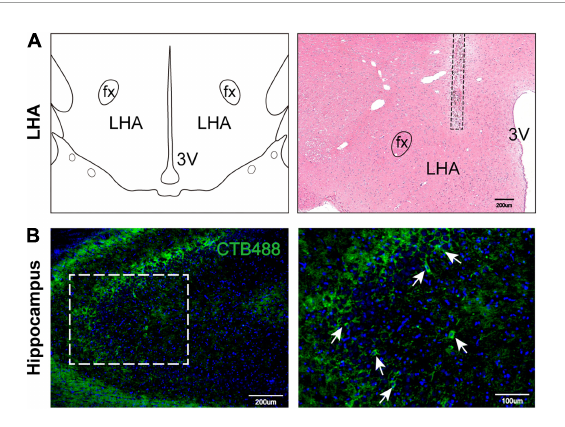
FIGURE4 Hypothalamic-hippocampal neural circuit. (A) Schematic representation of the microinjection site in the LHA on a coronal plane. H&E staining indicates the CTB488 injection site. LHA, lateral hypothalamic area; fx, fornix column; 3V, third ventricle. (B) The expression of marked hippocampal cells projecting to the LHA. Marked cells (green) and DAPI (blue). Scale bars, 200 µ m for low magnification images and 100 µ m for high magnification images. LHA, lateral hypothalamic area; 3V, 3 ventricle; fx: fornix column.